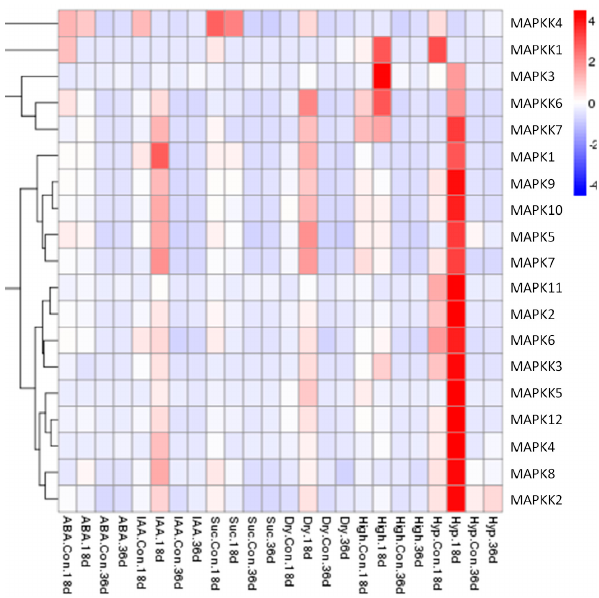
Figure 8. Expression patterns of FvMPK and FvMPKK genes in fruits after different stress pre-treatments. Red and blue boxes indicate high and low expression levels, respectively, for each gene. Six treatments: Abscisic acid (ABA), 100 μ M; indole-3-acetic acid (IAA), 100 μ M; Suc, sucrose 50 μ M; Dry, drought treatment; High, high temperature (40 °C); Low, low temperature (4 °C); Con., controlled trials of fruits without any pre-treatments; 18d., 18 DAF fruits; 36d., 36 DAF fruits.